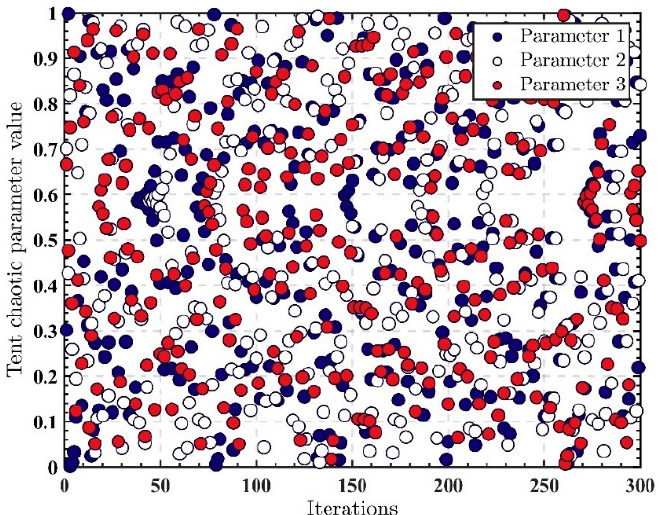
Figure 3. Schematic diagram of tent chaotic mapping.